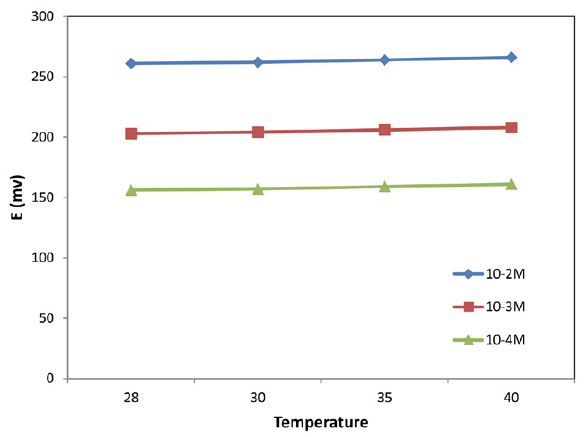
Fig. 10. Effect of temperature on the response of Lab sensor 2b